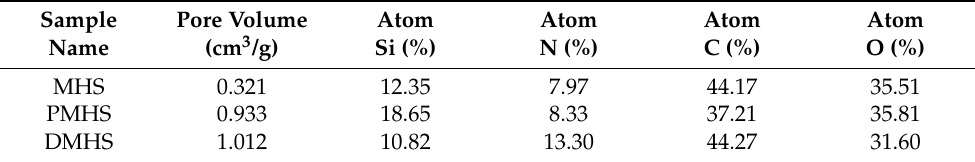
Table 3. Amine modification percentage of MHS, PHMS, and DMHS.